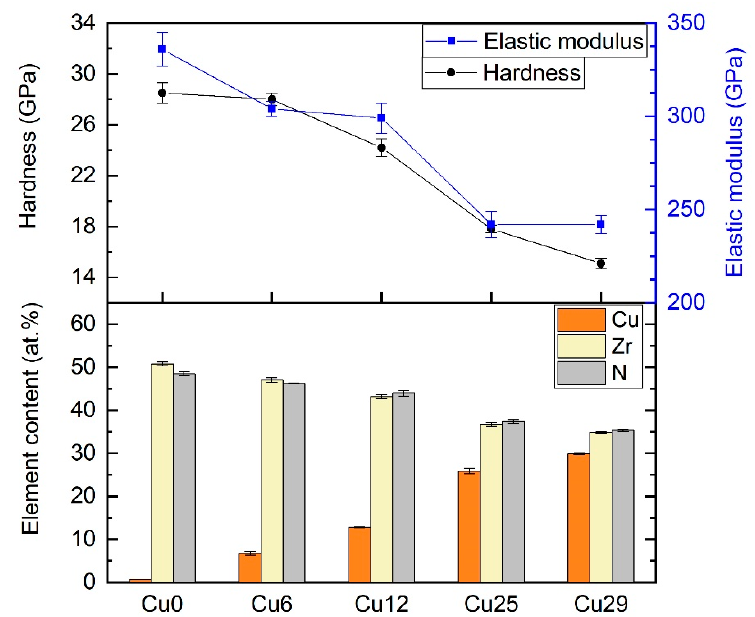
Figure 1. Chemical composition and mechanical properties of ZrN-Cu coatings.